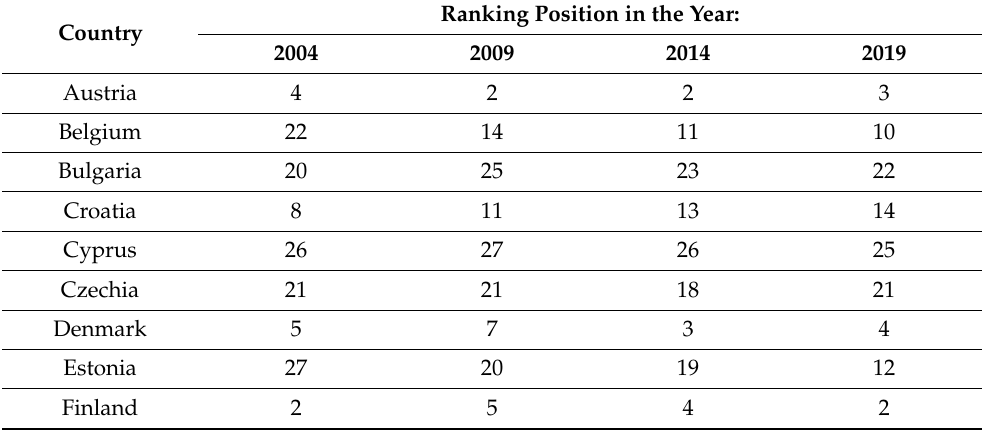
Table 1. The ranking of countries by level of RES use for electricity production for four selected years (alphabetical order). Ranking Position in the Year: Country 2004 2009 2014 2019